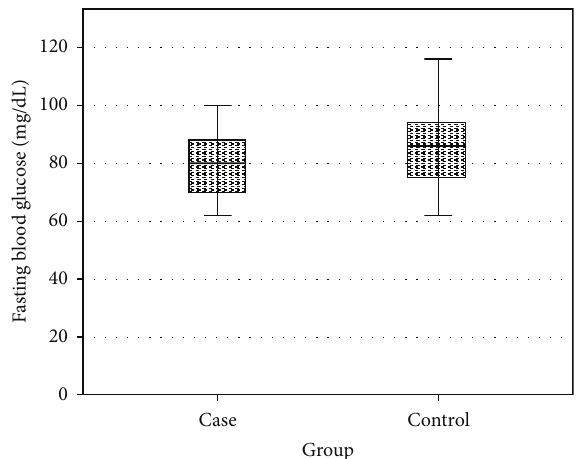
Figure 1: Comparison of fasting glucose levels in case and control